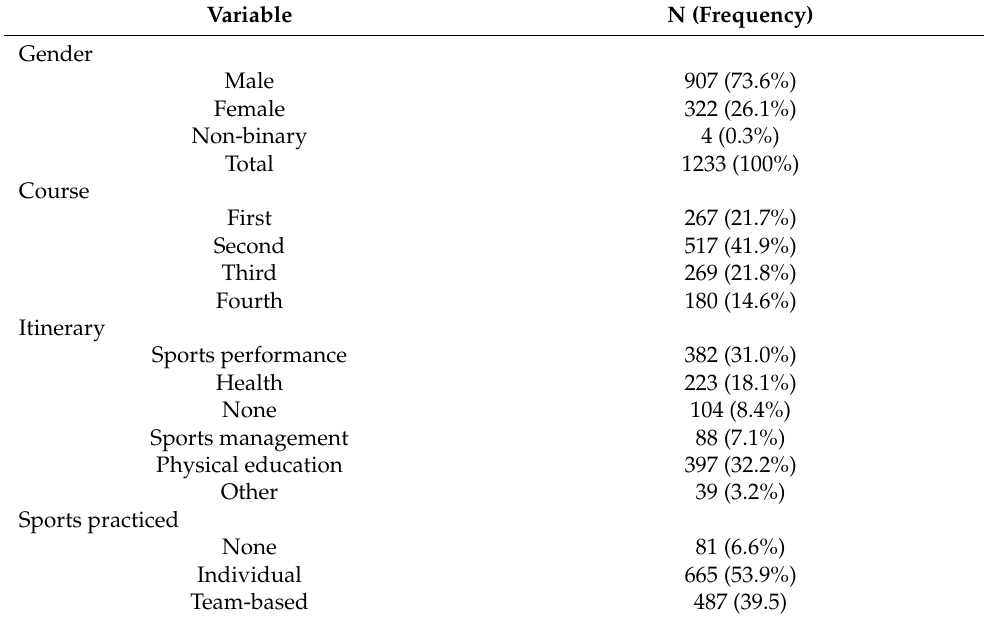
Table 1. Gender, course, itinerary, and type of sport practiced in a sample of 1233 bachelor students undertaking a degree in sports sciences of Spanish universities that were questioned about anti- doping knowledge. Variable N